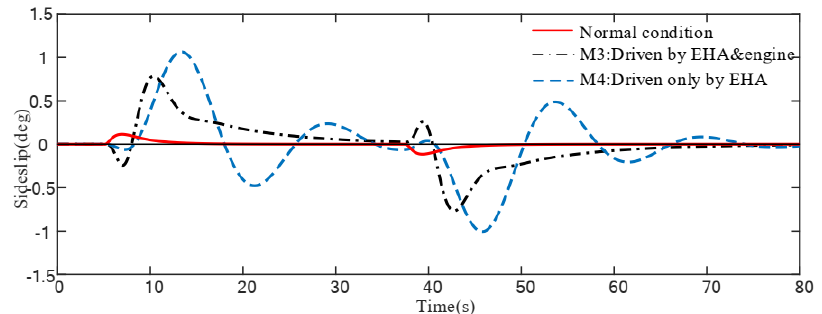
Figure 7. Heading angle response for damage scenario I.